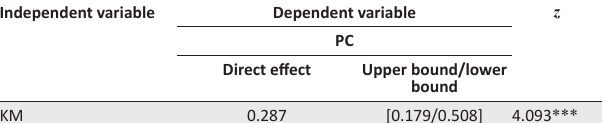
TABLE 7 : Validation of research hypothesis H